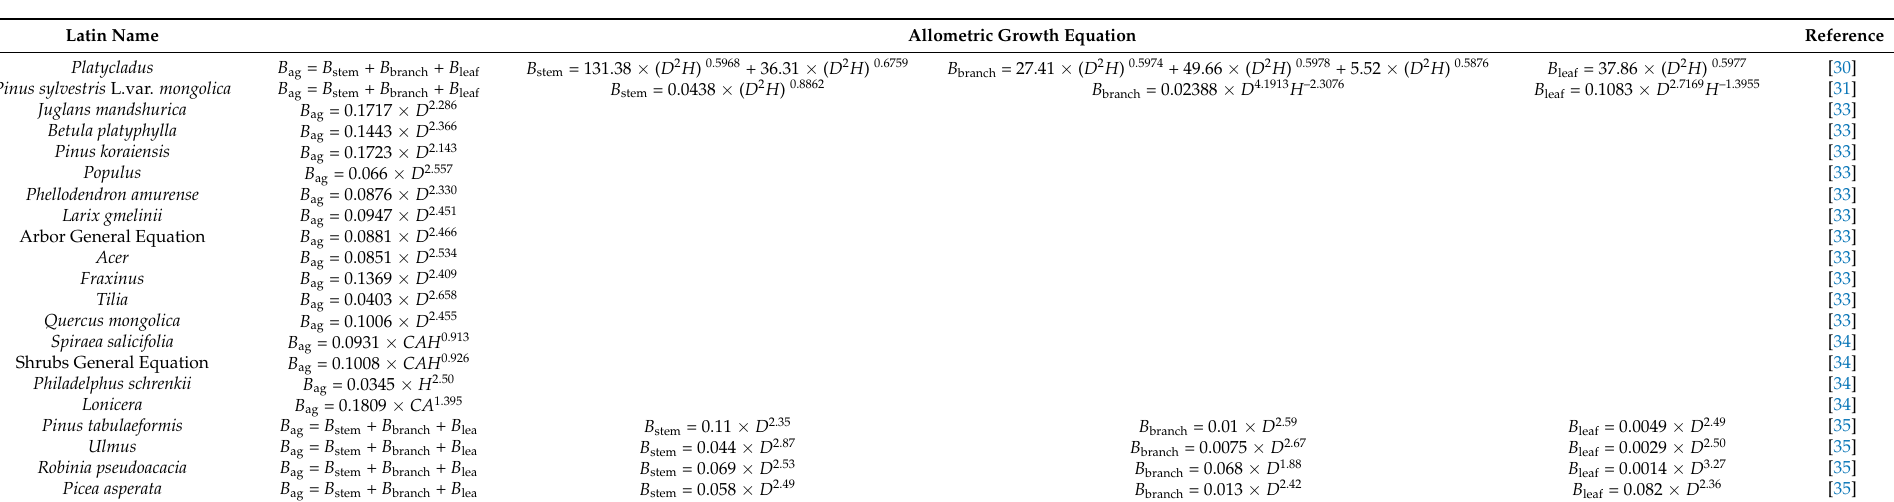
Table A1. Dry biomass equations of various trees and shrubs